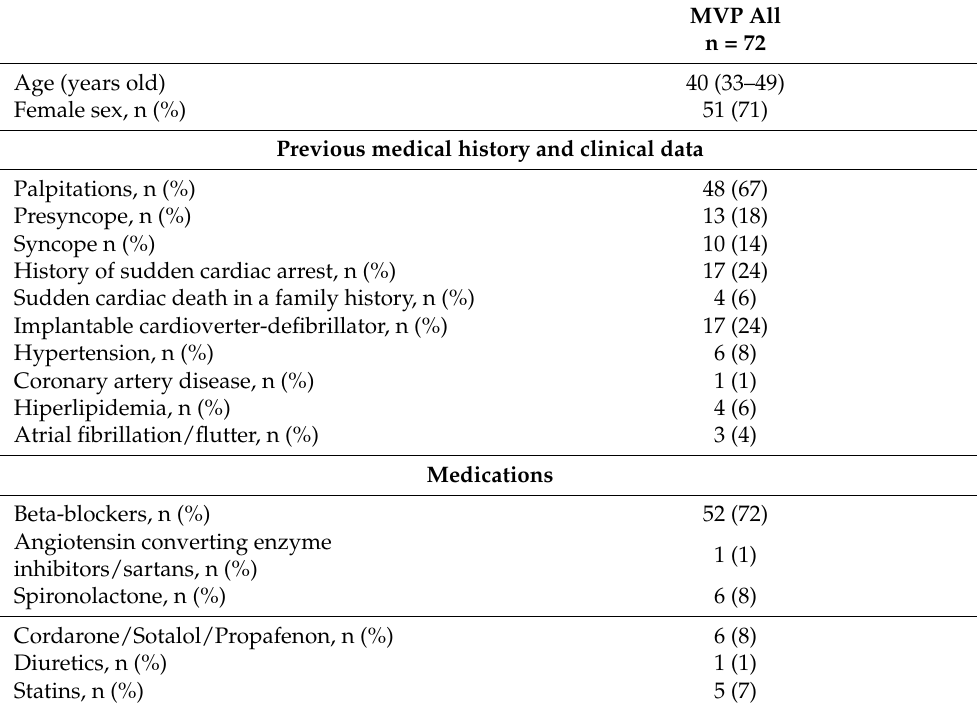
Table 1. Clinical characteristics of MVP patients.